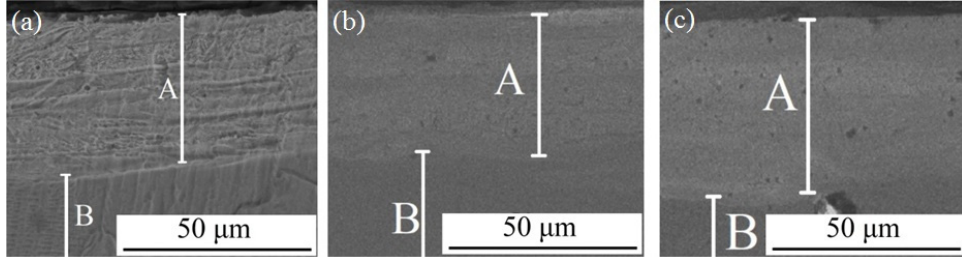
Figure 2. Cross-sectional SEM images of the specimens obtained after the ( a ) first cycle; ( b ) second cycle; and ( c ) third cycle. (A) Ti-Ta alloyed zone; (B) base titanium substrate. Table 1. Chemical composition of the Ti-Ta coatings formed after each cycle. Specimen Ti, wt.%